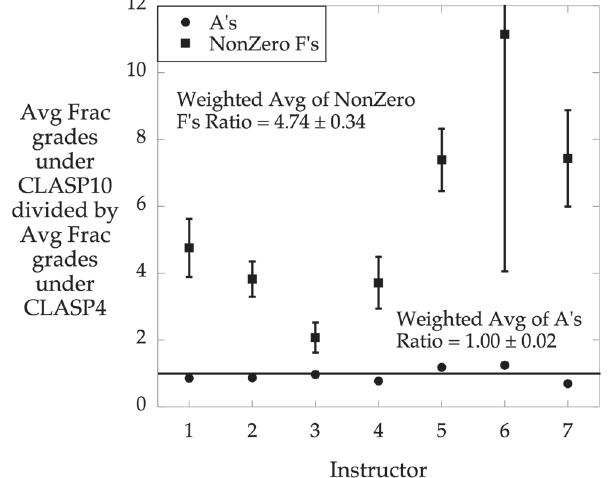
FIG. 1. Each of seven instructors taught under both grade scales. The figure shows both the ratio of their class-averaged fraction of A grades under CLASP10 and that fraction under CLASP4 and the similar ratio for nonzero F grades. A horizontal line is drawn at a ratio of 1 where grades are awarded equally under the two scales. We see that these instructors treated A grades roughly the same under the two grade scales even though they treated nonzero F grades very differently. The error bars are estimated standard errors.